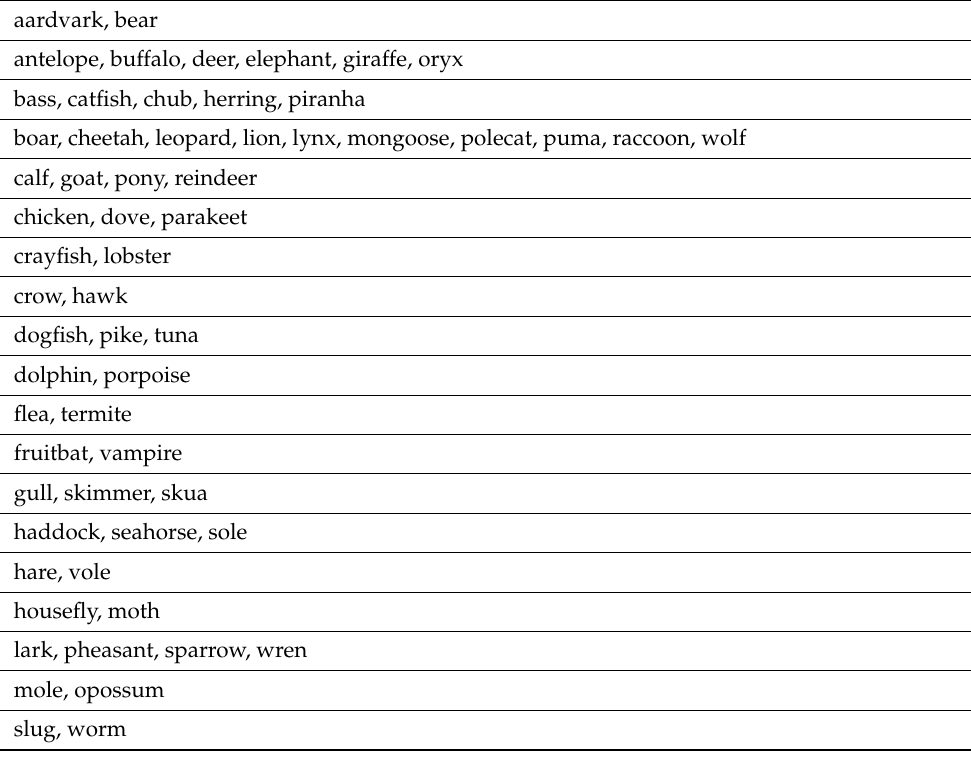
Table A1. Animals with the same input